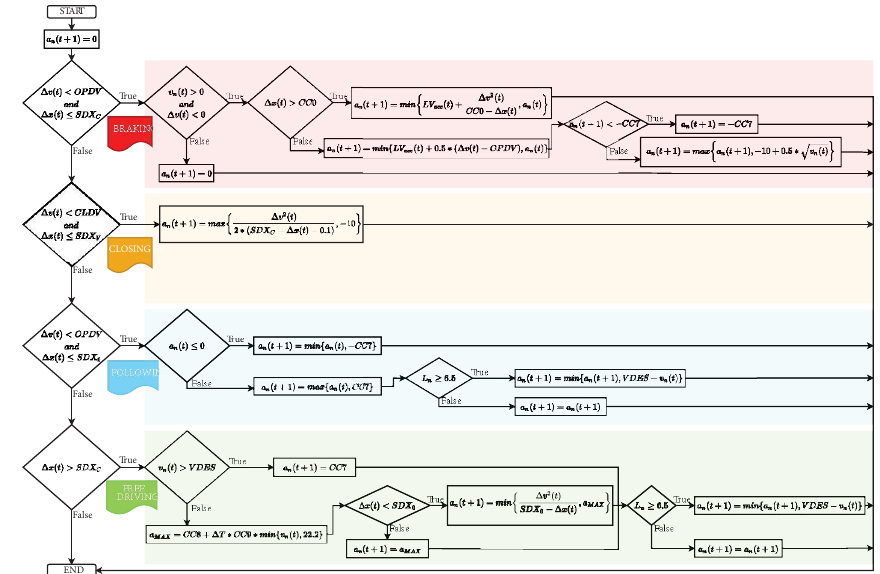
Figure 2: Process of calculation regarding the follower’s acceleration in the W99 model modifed from Zhu et al. [18]. Table 1: Standstill gap (CC0) and time headway (CC1) values for the Wiedemann 99